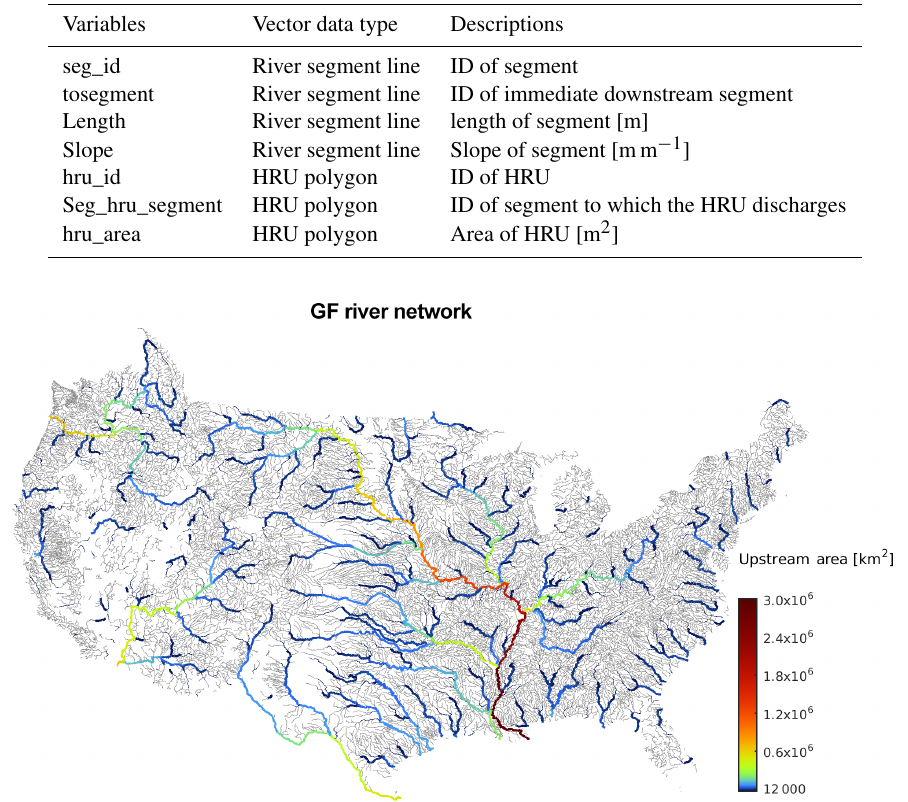
Figure 4. GF river network color coded by upstream drainage areas. Gray lines indicate the total upstream drainage areas less than 12000km 2